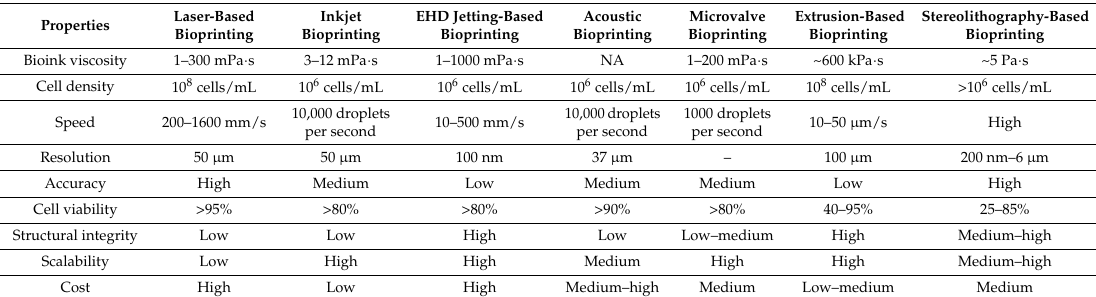
Table 4. A comparison of various bioprinting techniques as tabulated by Vijayvenkataraman et al. [51].